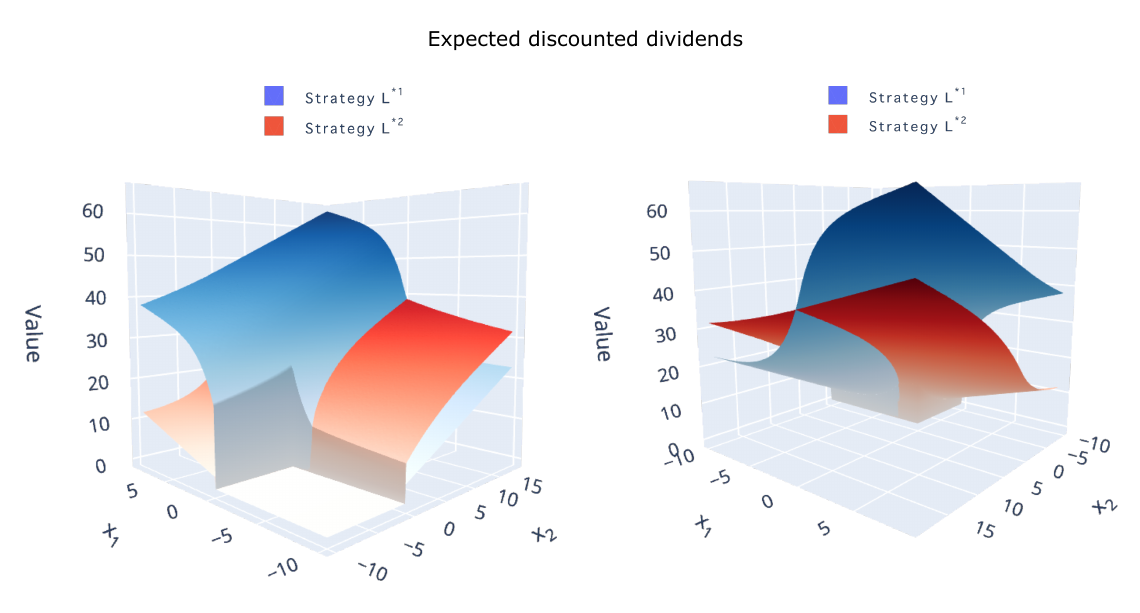
= 8.0, x b = 18.35 2 1